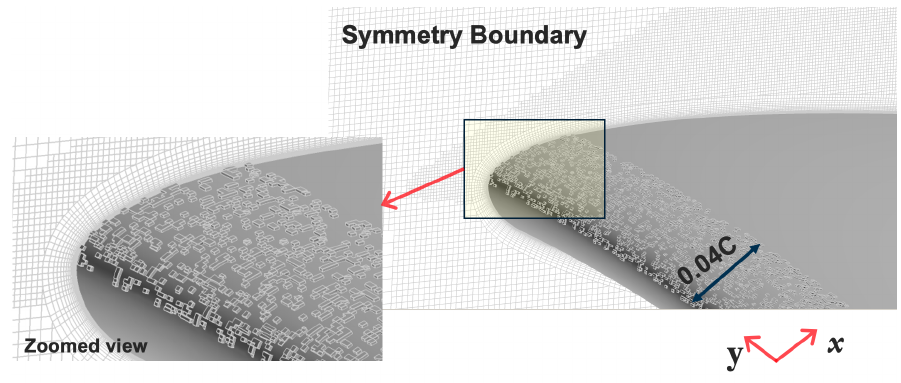
Figure 4. Roughness elements distribution in the leading edge of the foil.